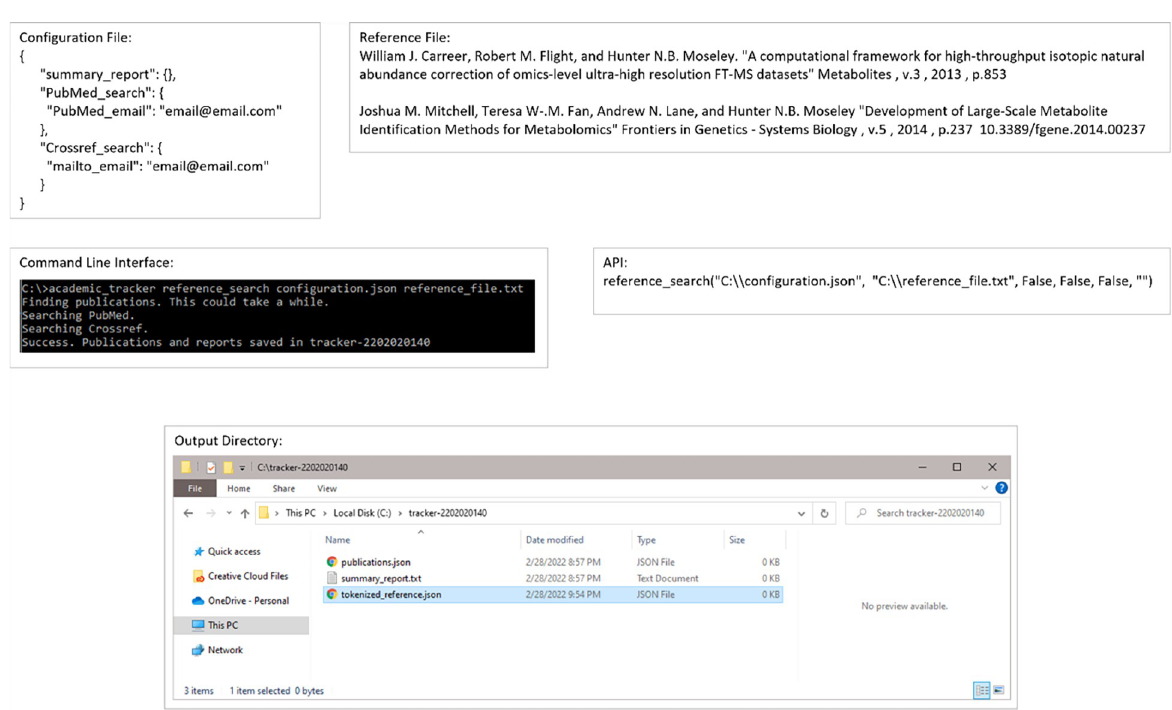
Fig 5. Example execution of the reference_search use-case. Example configuration file, reference file, command-line execution, API execution, and file output of the reference_search use-case shown.